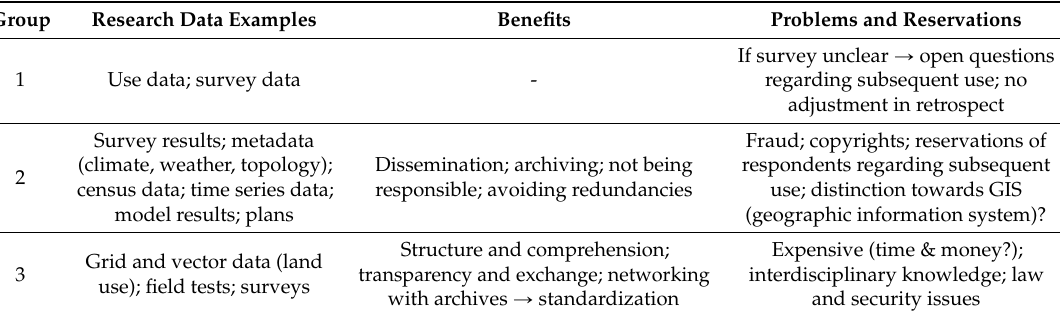
Table 1. Answers of participants regarding research data